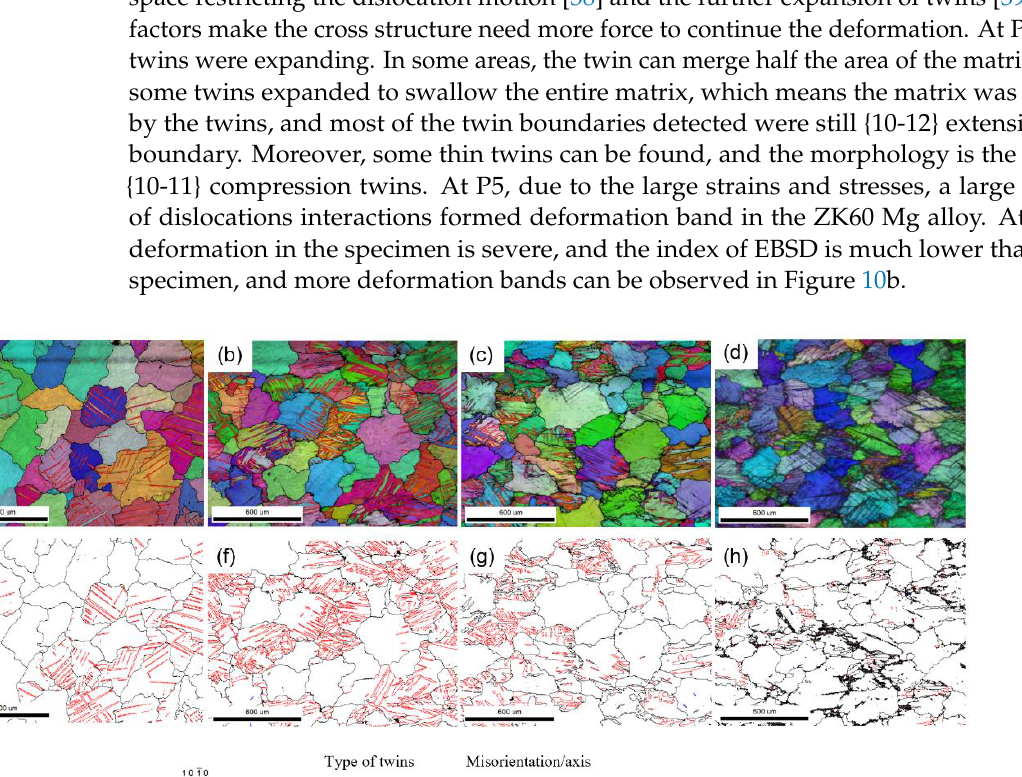
Figure 8. ( a )The IPF map and ( b ) metallography at P1.